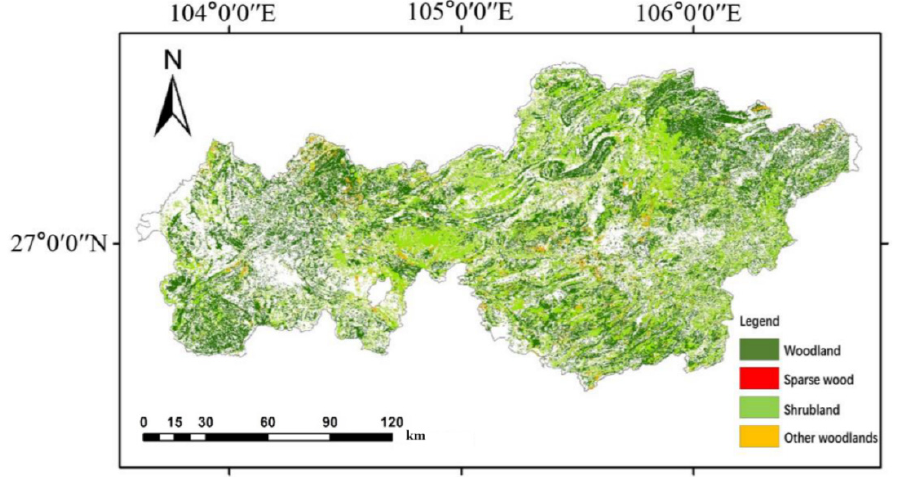
Figure 2. Spatial distribution map of forest land types in Bijie City.